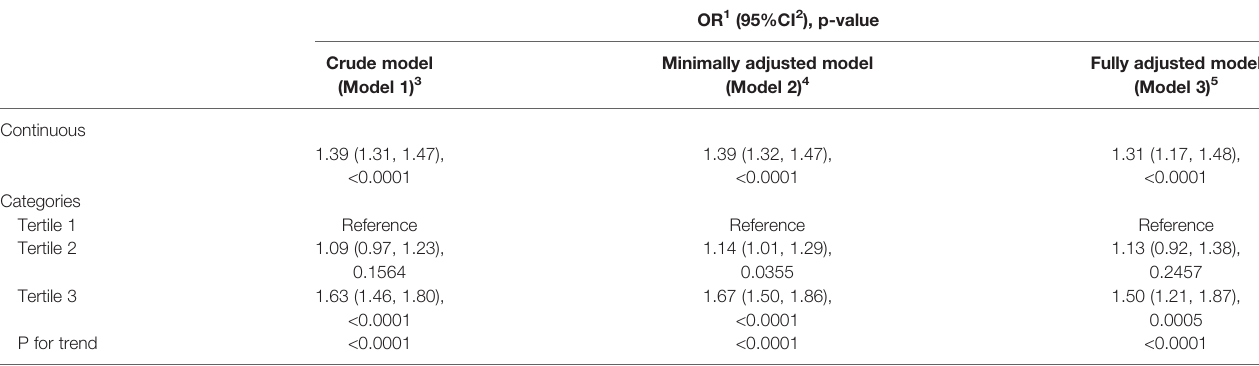
TABLE 2 | Association Between Systemic Immune-In fl ammation Index and